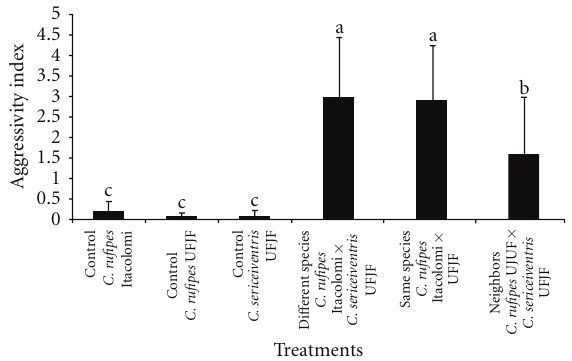
Figure 4: Aggressiveness index (mean and standard deviation) for each treatment of laboratory experiments (dyadic encounters) in which “control” is the manipulation with individuals from the same colony and species; “di ff erent species” between C. rufipes from Itacolomi State Park (Itacolomi) and C. sericeiventris from Campus of Federal University of Juiz de Fora (UFJF); “same species” between C. rufipes from both Itacolomi and UFJF; “neighbours” between C. rufipes and C. sericeiventris from